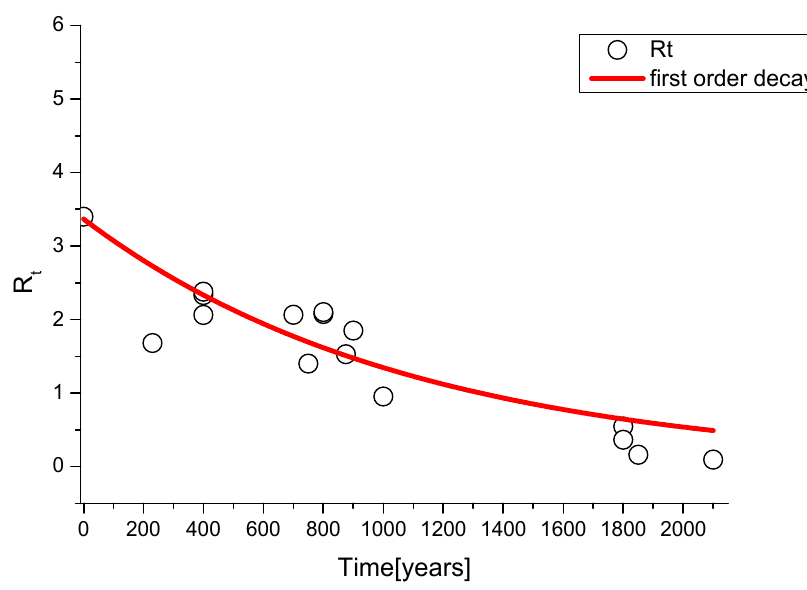
Figure 2. First order decay fit to obtain an average R 0 value from literature points.